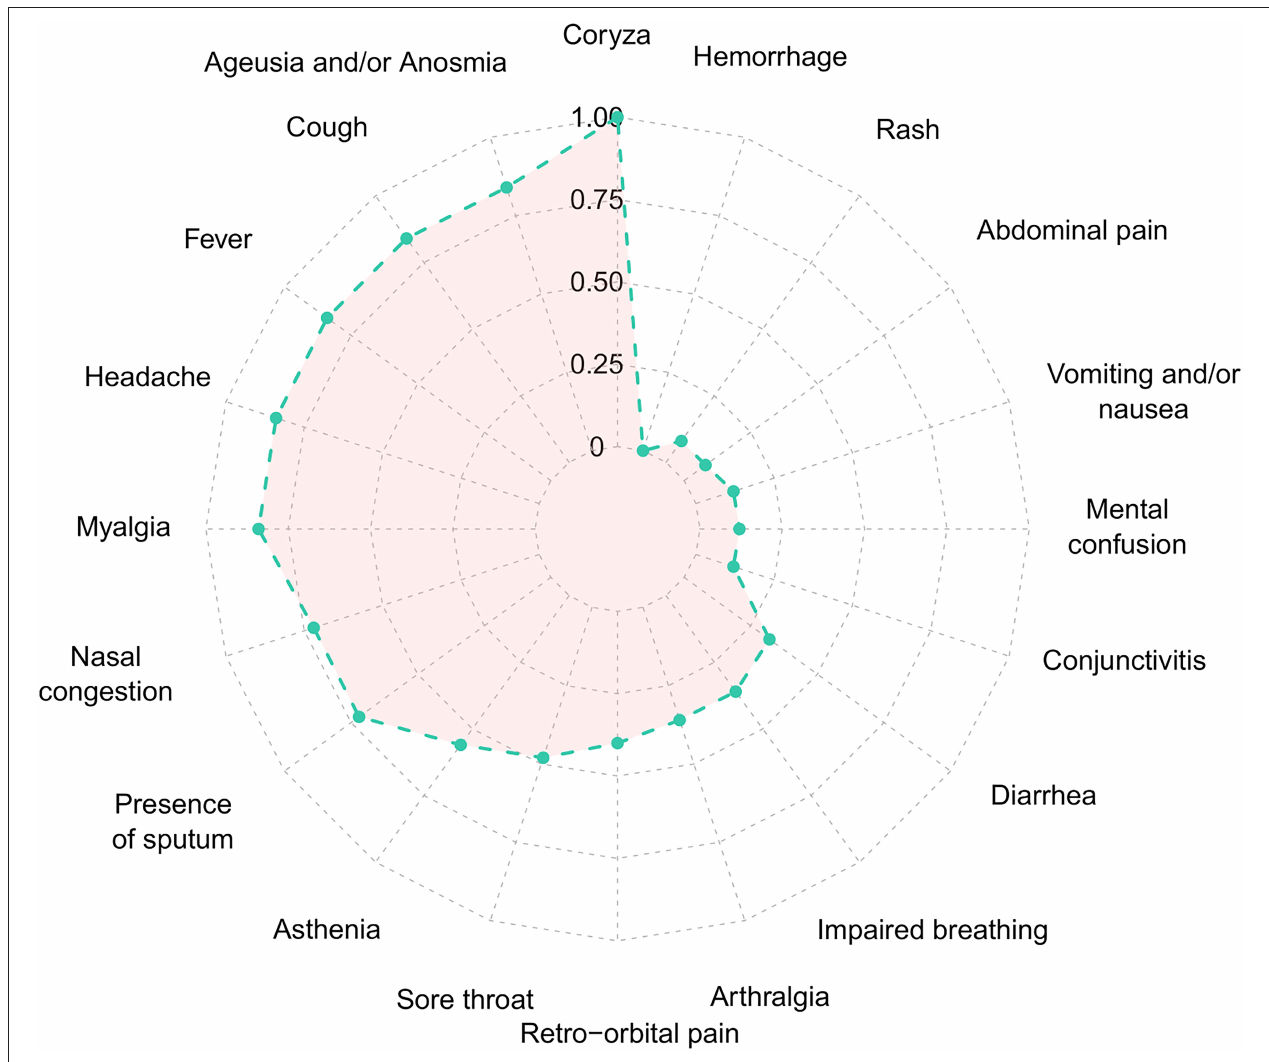
FIGURE 2 | Frequency of each symptom of the Coronavirus Disease 2019 in the 38 SARS-CoV-2 positive patients. Normalized frequency considering the presence of the symptom with the lowest ( n = 1) and highest ( n = 26) value, to values between 0 and 1. SARS-CoV-2, severe acute respiratory syndrome coronavirus 2.